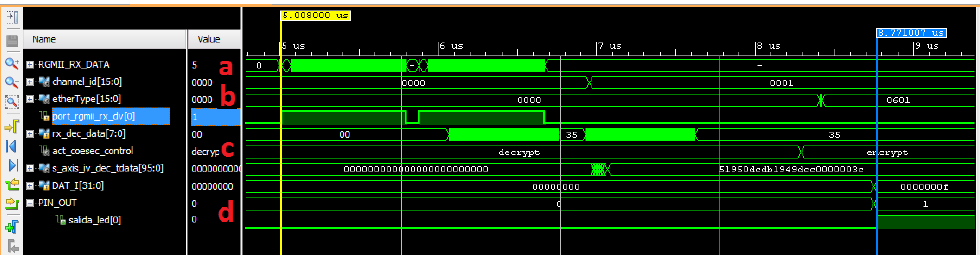
Figure 6. COEsec module simulation for writing frame. ( a ) The frame is captured (i.e., writing process) initially. ( b ) Verify whether the Ethertype and Channel ID fields are valid. ( c ) The frames stored in